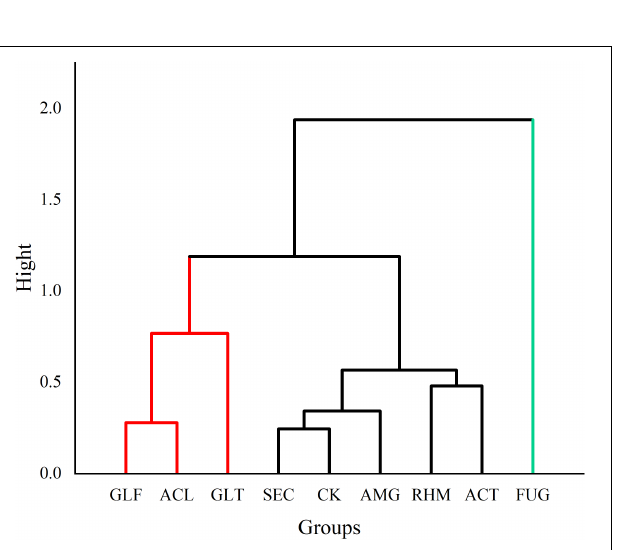
FIGURE 3 | UPLC for partial samples of S. miltiorrhiza root and the simulative mean chromatogram (R).